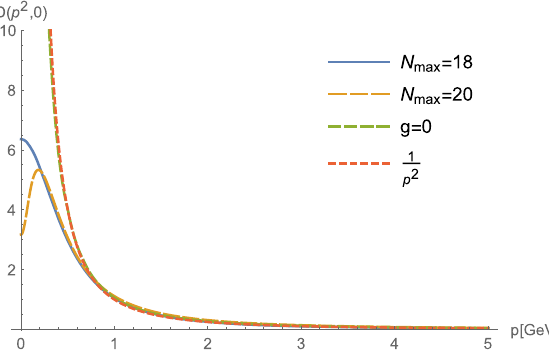
Fig. 3 Two types of gluon propagators with the Hermite functions of truncation order N max = 18 and N max = 20, together with the free field propagator. The gluon propagator with same parametrization as N max = 20 but with zero coupling g = 0 is also depicted, which coincides with the free field